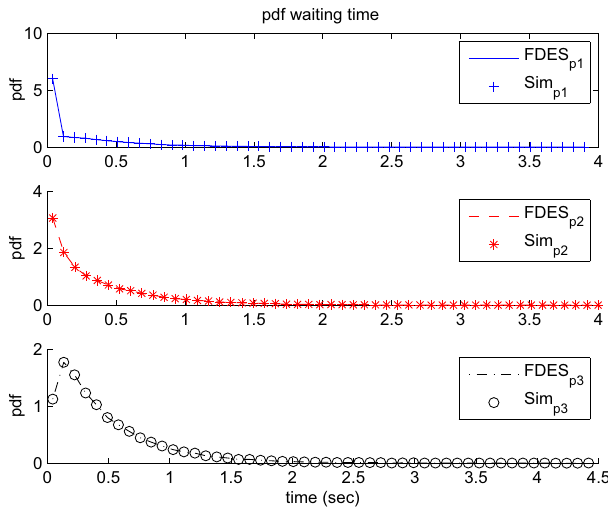
Figure 5: pdf of the waiting time of input queues of the multiplexer utilizing FDES and SimEvents.